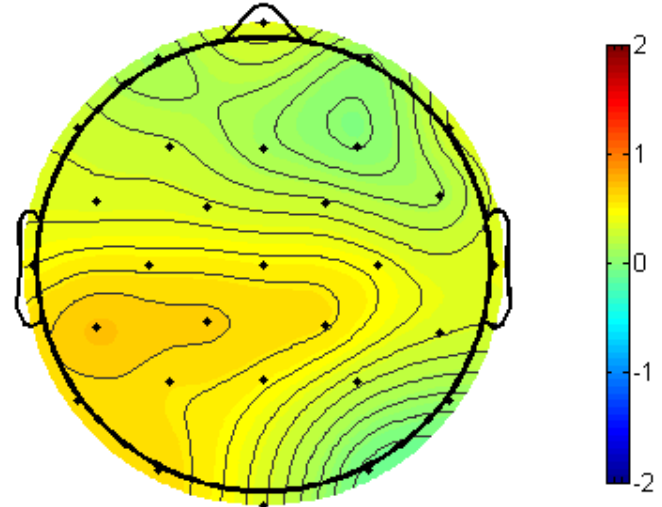
Figure 10. The 300–500-ms voltage map of L1 translation lexical relatedness priming e ff ect for Figure 10. The 300 – 500-ms voltage map of L1 translation lexical relatedness priming effect for semantically unrelated targets (lexically unrelated translations–lexically related semantically unrelated targets (lexically unrelated translations – lexically related translations).